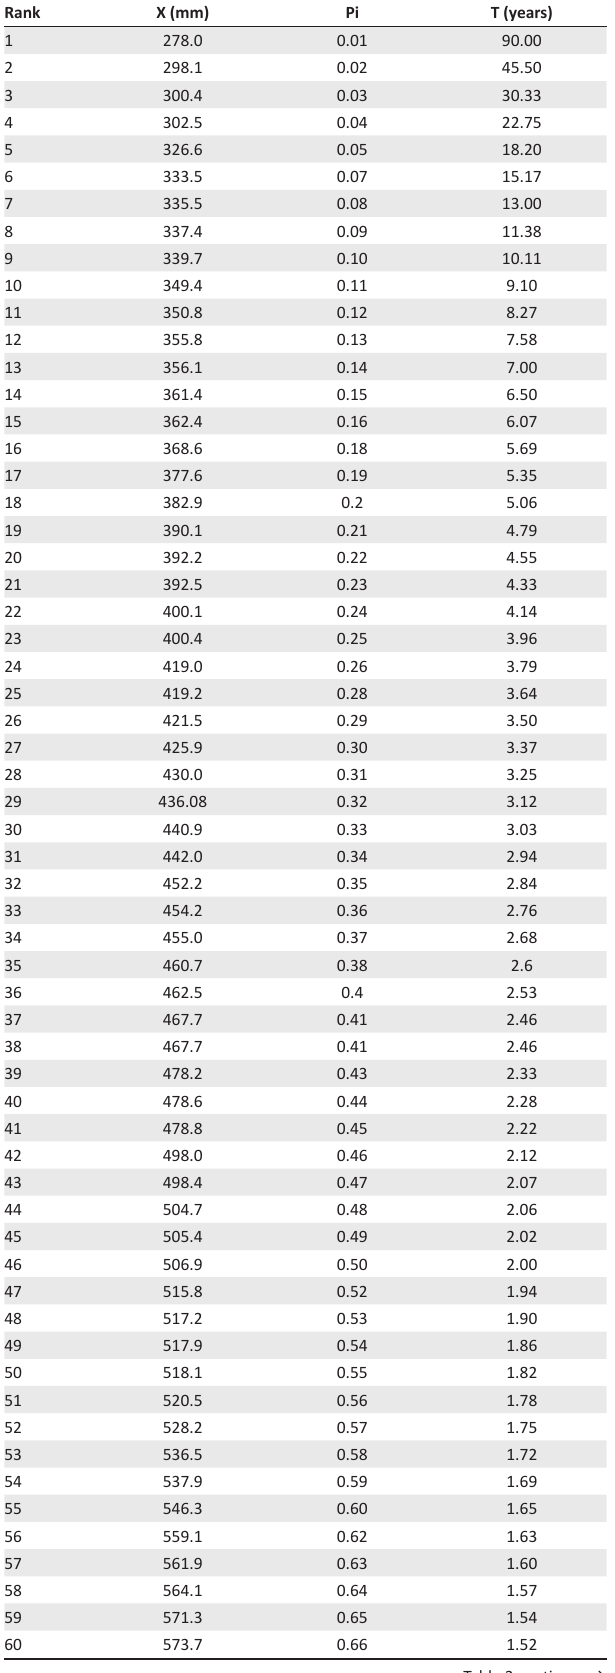
TABLE 3: Rainfall totals, plotting positions and return periods of maize prone to agricultural drought in the growing period of October to December in the rainfall zone X3C.